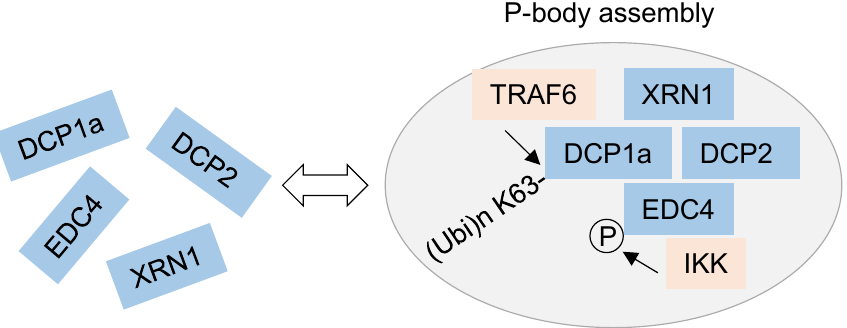
Figure 3. The impact of NF- κ B-derived phosphorylations and ubiquitinations on P-body assembly and function. Regulators of the NF- κ B pathway are shown in light red; for further details, see text. It is well established that inflammatory gene expression is also regulated at the level of ribosomal translation [102,103], but the information on NF- κ B-derived signals for de